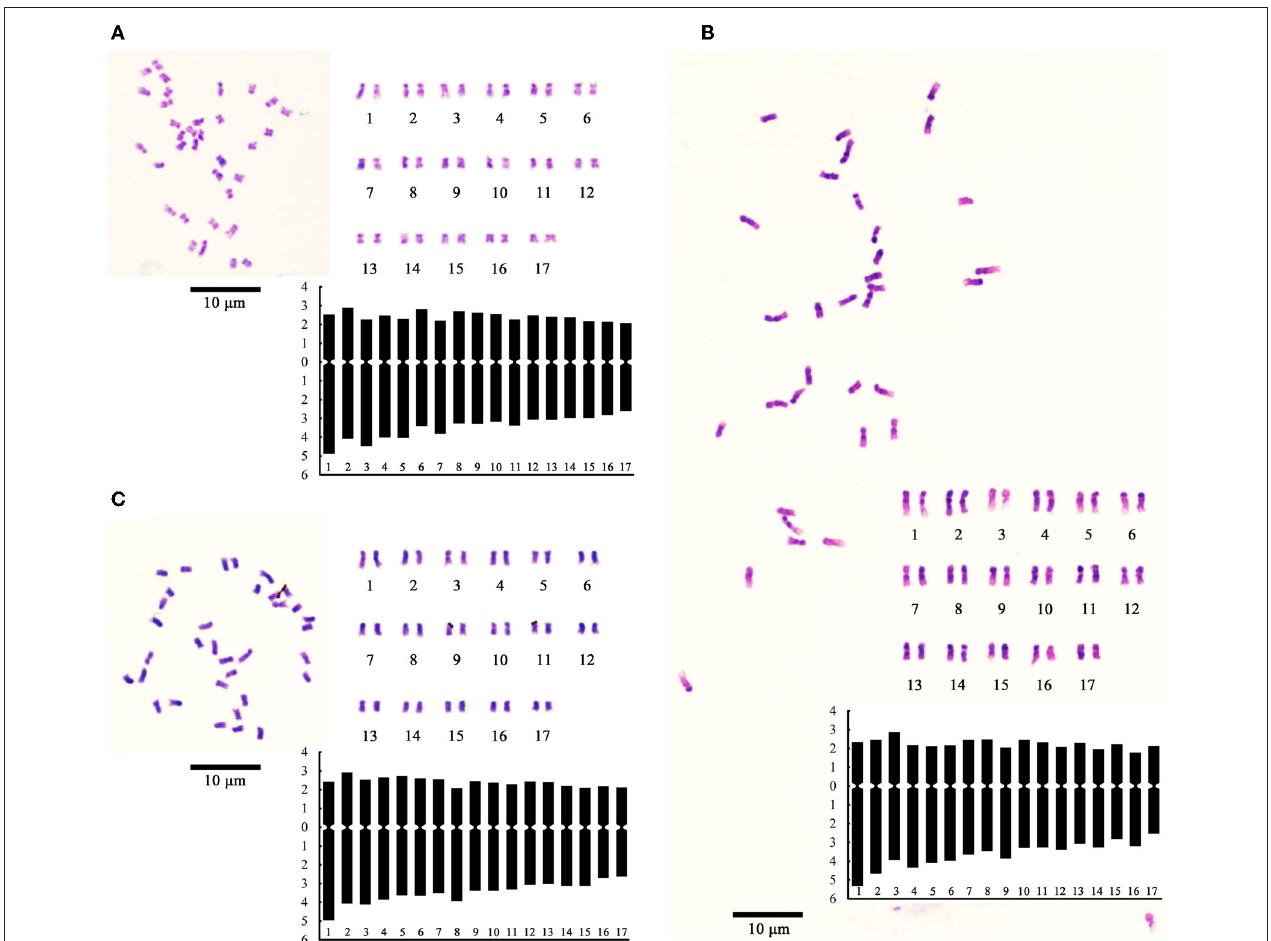
FIGURE 8 | Images of chromosome photo, karyogram, and ideogram: (A–C) showing chromosome images, karyograms, and idiograms of H30-6, H411, and B336 respectively. 2013). In most species, homologous chromosomes do not